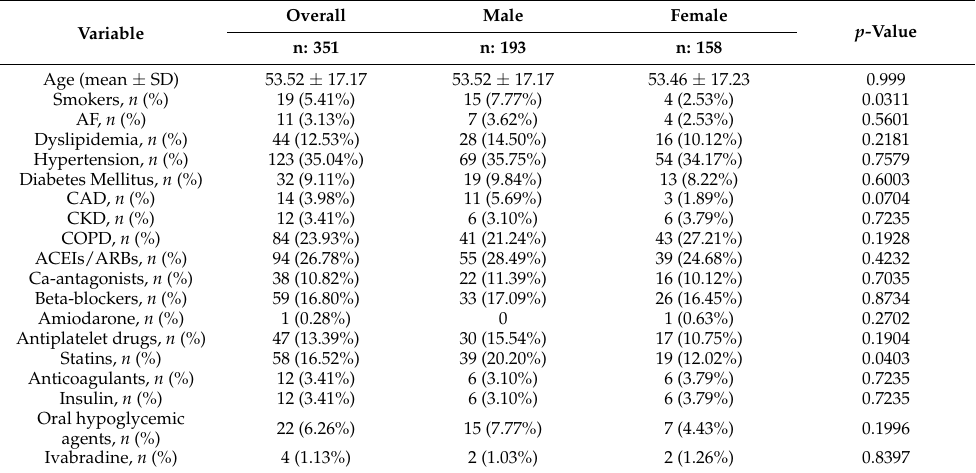
Table 1. Patients’ characteristics and sex distribution among the overall COVID-19 study population.